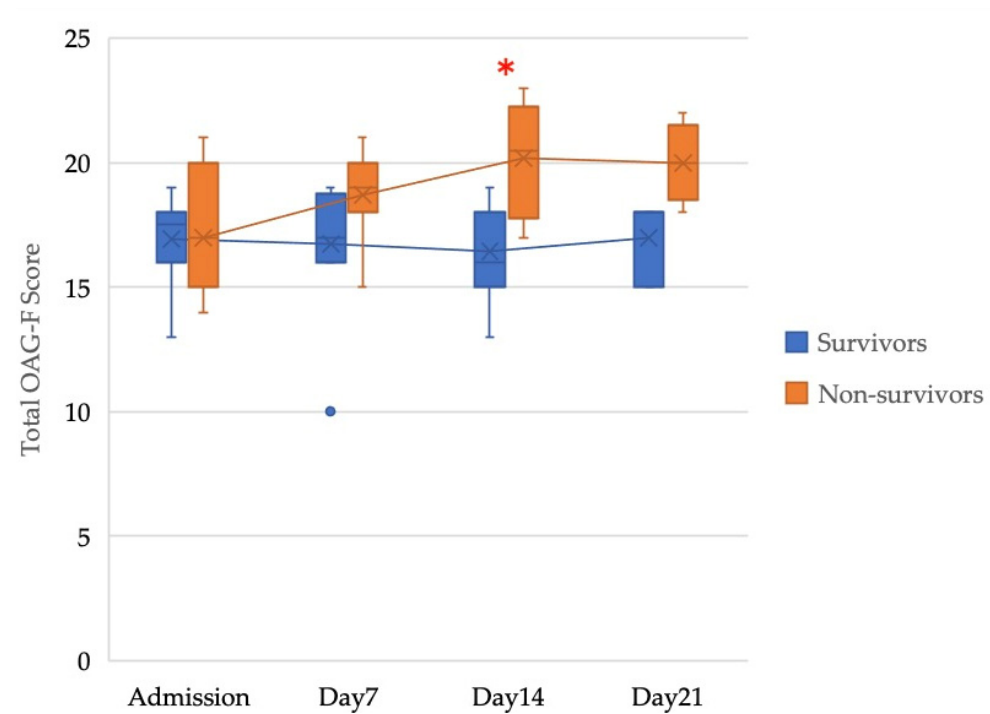
Figure 2. The time-course changes in the total OAG-F score. (Admission) Survivors: n = 12, Non- survivors: n = 7. (Day 7) Survivors: n = 12, Non-survivors: n = 7. (Day 14) Survivors: n = 7, Non- survivors: n = 6. (Day 21) Survivors: n = 3, Non-survivors: n = 5. * Asterisk indicates a statistically